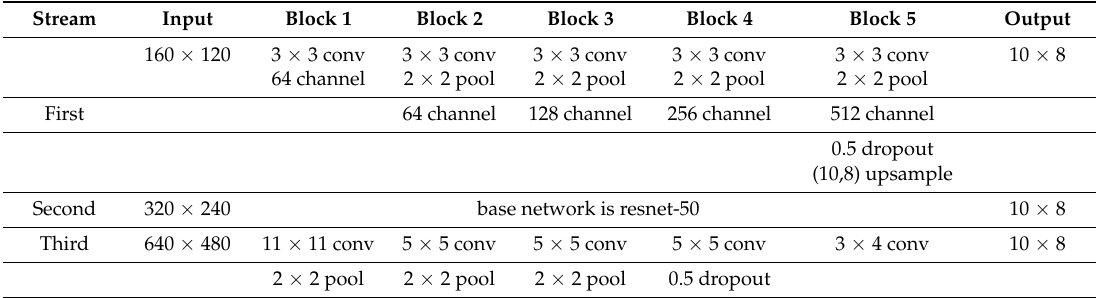
Figure 2. Upconvolution structure. This structure is similar to upprojection [30], but in this paper the symmetry convolution is replaced by asymmetric convolution. This version is more efficient and can speed up the process of training. By using this structure, the scale of the feature map is doubled, while the depth value can be reduced by half ([W, H, D]->[2W, 2H, 0.5D]). Following the three–stream and four novel upconvolution structures, dropout is applied and predicts that the target depth is output by the last layer. The exact network configurations we used in our experiments are shown in Table 1. Table 1. Pyramidal third-streamed network (PTSN) architectures for the NYU Depth v2 [18] dataset.